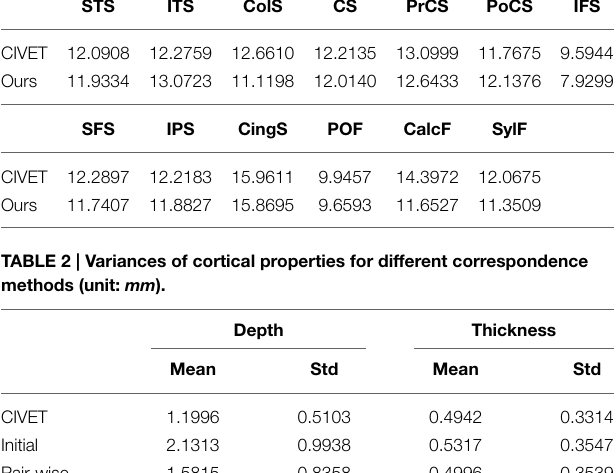
TABLE 1 | Sulcal curve entropy measured based on the proposed metric. STS